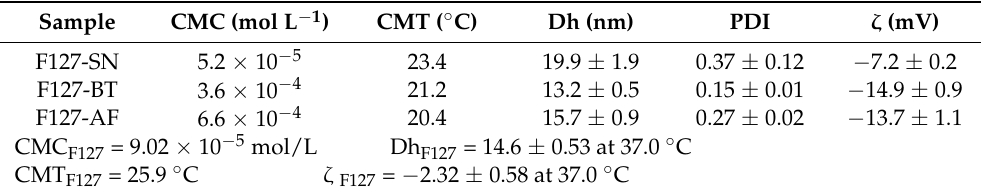
Table 1. Micelles characterization: critical micellar concentration (CMC), critical micellar temperature (CMT), hydrodynamic diameter (Dh), polydispersity (PDI), and zeta potential ( ζ ). Dh, PDI, and ζ were performed at 37.0 ◦